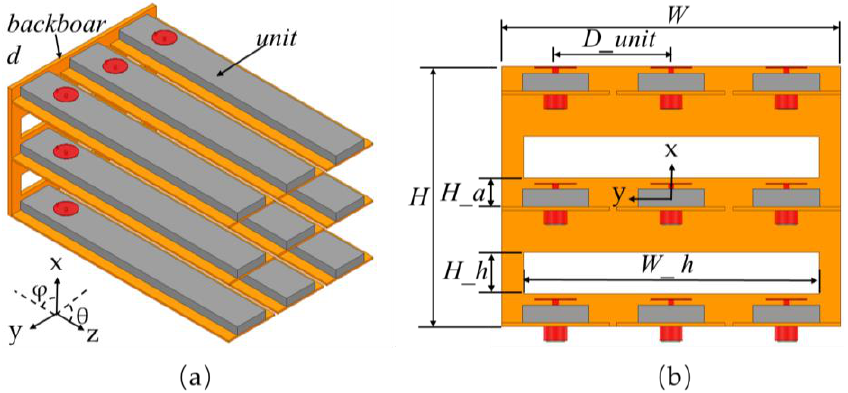
Figure 5. Configuration of the proposed antenna array: ( a ) main view, ( b ) front view.